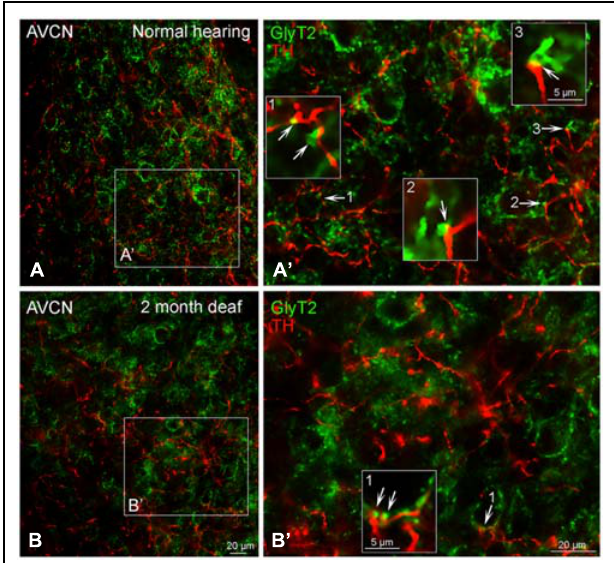
FIGURE 7 | In the AVCN the distribution of GLYT2 (green) overlaps with TH (red). Labeling for GLYT2 is localized to glycinergic terminals with TH labeling primarily localized to complimentary terminals and dendrites (A,B) with a few areas of co-localization (yellow). Following deafness GLYT2 labeling is decreased. Arrows indicate closely associated puncta. (A’) – an enlargement of square in (A) . (B’) – an enlargement of box in (B) . Numbers and arrow in (A’) and (B’) indicated enlarged regions in (A’,B’) with arrows showing co-localization (yellow) and close apposition between GLYT2 and TH. Scale bar: 20 μ m.